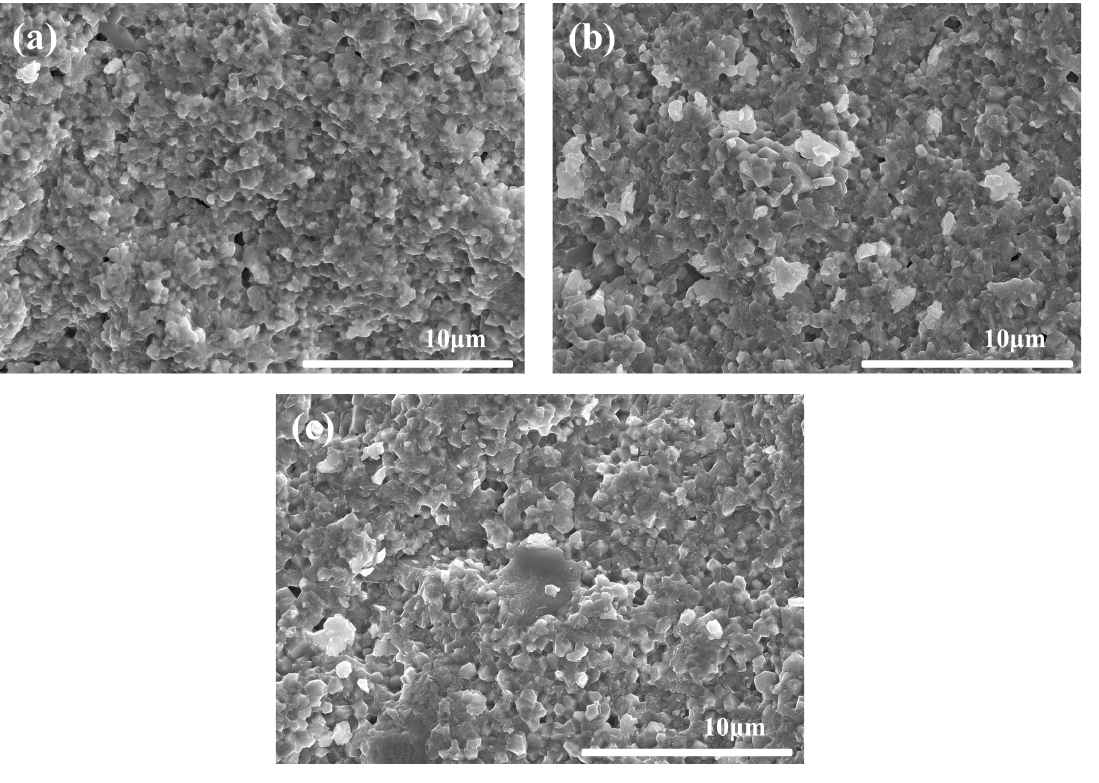
Figure 13. Fractural morphologies of the sintered parts at different sintering temperatures for 2 h.